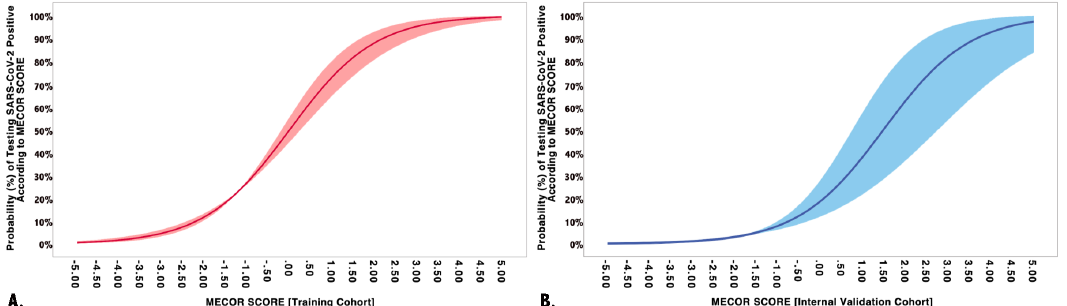
Figure 2. Multivariate model performance in training and validation cohorts. ( A ) The training cohort on the vertical axis represents the probability of being SARS-CoV-2 positive according to the Model for possible Early COvid-19 Recognition (MECOR) Score (horizontal axis). Logistic regression coefficients of probability are represented with robust 95% confidence intervals (light red area); ( B ) the validation cohort on the vertical axis represents the probability of being SARS-CoV-2 positive according to the MECOR Score (horizontal axis). Logistic regression coefficients of probability are represented with robust 95% confidence intervals (light blue area).